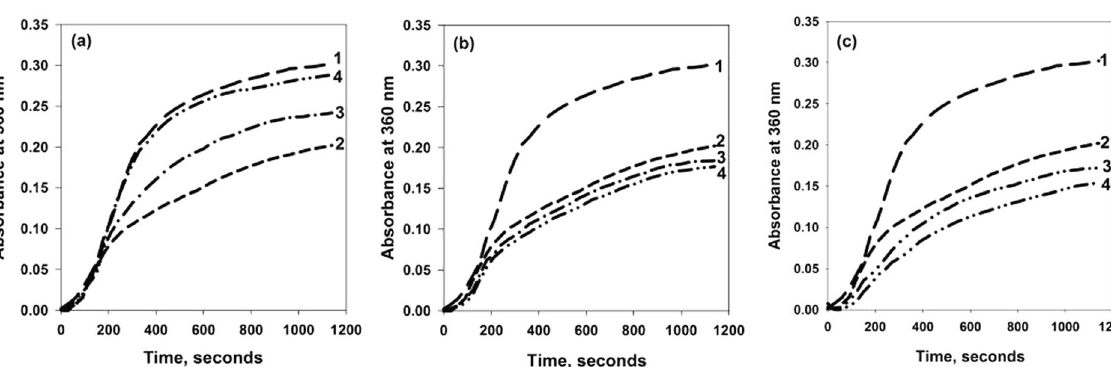
Figure 3. Effect of TMAO, sarcosine, and betaine on the molecular chaperone activity of α -casein: Activity measurement of α -casein in presence of TMAO ( a ), sarcosine ( b ) and betaine ( c ) by light scattering at 360 nm. Curve 1 (catalase control), curve 2 (catalase in presence of α -casein, unincubated with osmolyte), curve 3 (catalase in presence of α -casein, briefly incubated with 1 M TMAO, sarcosine or betaine for less than 30 seconds), curve 4 (catalase in presence of α -casein, incubated overnight with 1 M TMAO, sarcosine or betaine). TMAO, sarcosine and betaine alone do not influence aggregation behavior of catalase, data not shown. Each aggregation kinetics of catalase (curves 1–4) was initiated upon immediate addition of α